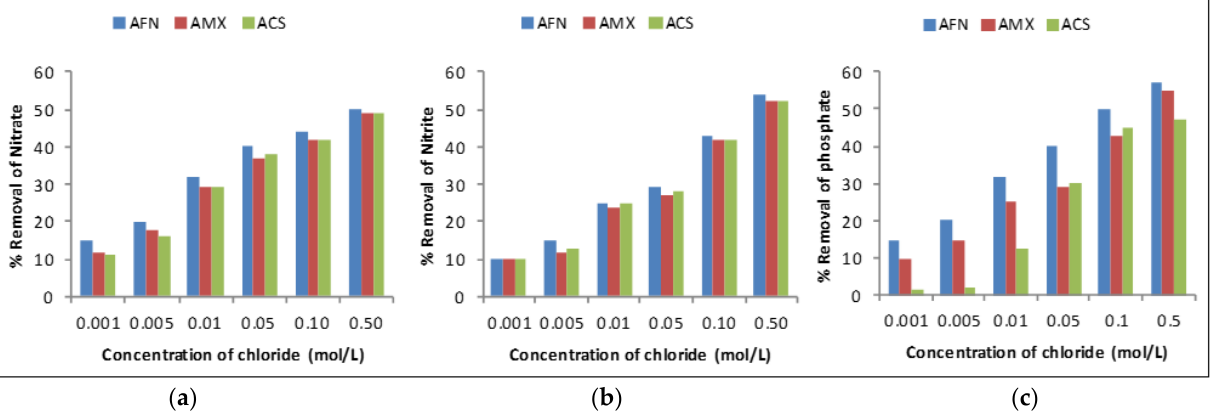
Figure 12. The effects of the counter-ion concentration (chloride) on the removal rates of nitrate ( a ), nitrite ( b ) and phosphate ( c ). Adapted from [109].